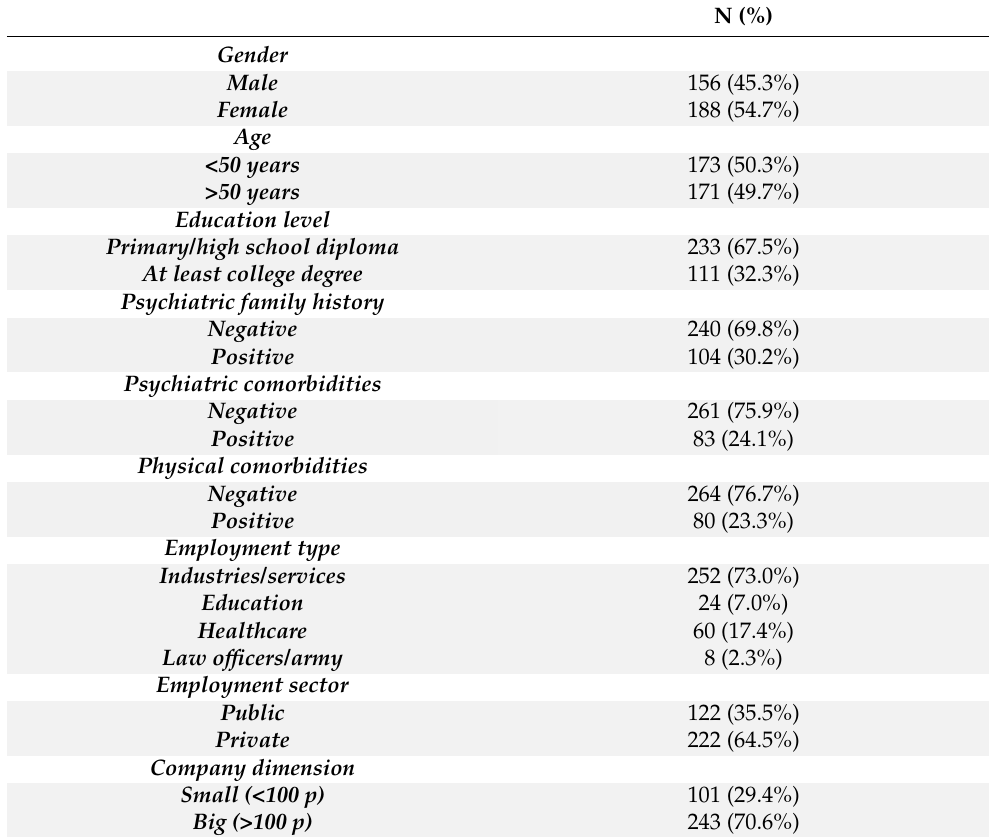
Table 1. Sociodemographic and work-related characteristics of the overall sample (N = 345) with mean ± SD age of 49.8 ±